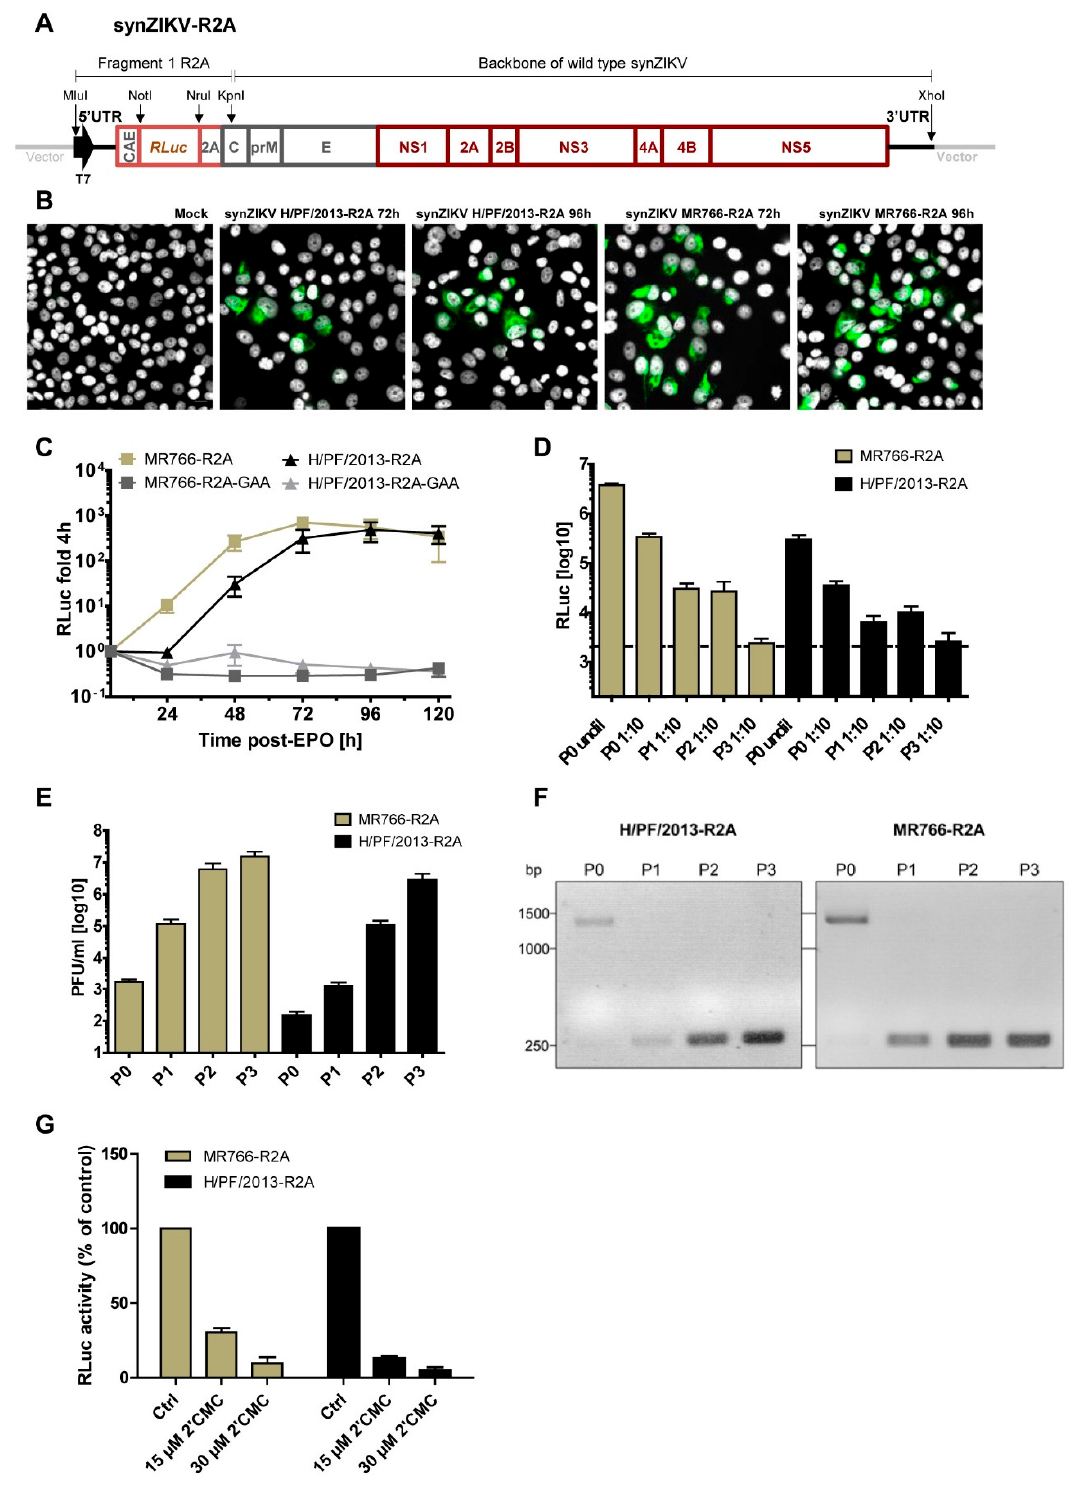
Figure 3 . Construction and characterization of synZIKV-R2A reporter virus genomes. ( A ) Schematic representation of the synZIKV-R2A reporter virus genomes. For both strains the R2A reporter cassette (light red) was inserted into the wild-type pFK-synZIKV plasmids via MLuI/KpnI restriction sites. The NotI/NruI sites flanking the RLuc gene allow for the exchange of the reporter gene. ( B ) Immunofluorescence analysis of VeroE6 cells transfected with synZIKV-R2A in vitro transcripts. Cells were grown on coverslips, fixed 72 h and 96 h after transfection and stained with E-specific antibody (green). Nuclear DNA was counterstained with DAPI (grey). Scale bar = 15 μ m. ( C ) Replication kinetics of the synZIKV-R2A reporter viruses in VeroE6 cells. After electroporation (EPO) cells were